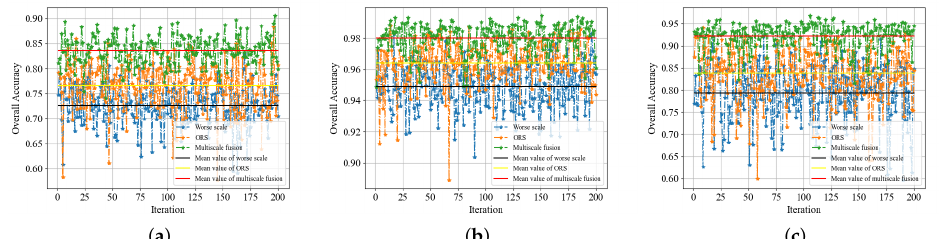
Figure 5. OAs of different scales for 200 iterations on three HSI datasets. The ORS selected by ORSSA, worse single scale, and randomly selected multiscale fusion are labeled in orange ‘*’, blue ‘*’ and green ‘*’ , respectively. The three horizontal lines are the mean values of 200 iterations, that is, the bias of different manners. The “*” curves can reflect the variances of different manners. The number of training samples are 3 per class. ( a ) Indian Pines. ( b ) Salinas ( c ) University of